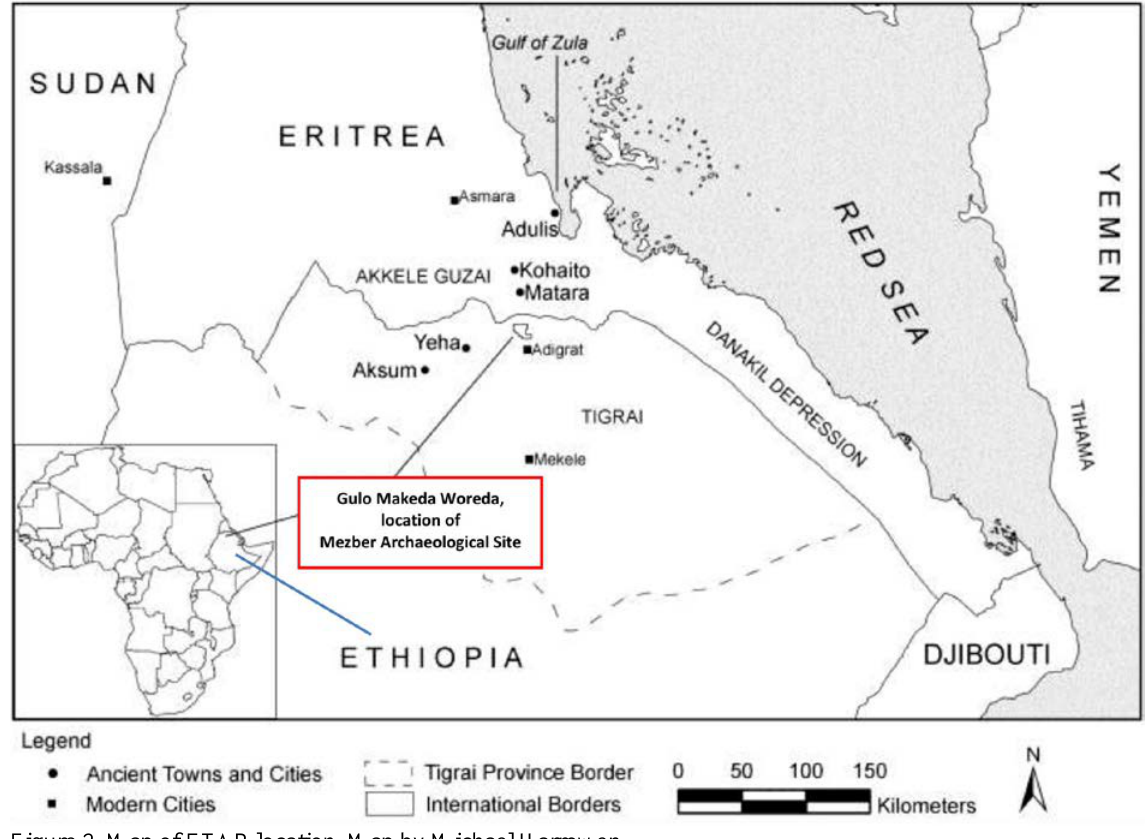
Figure 2. Map of ETAP location. Map by Michael